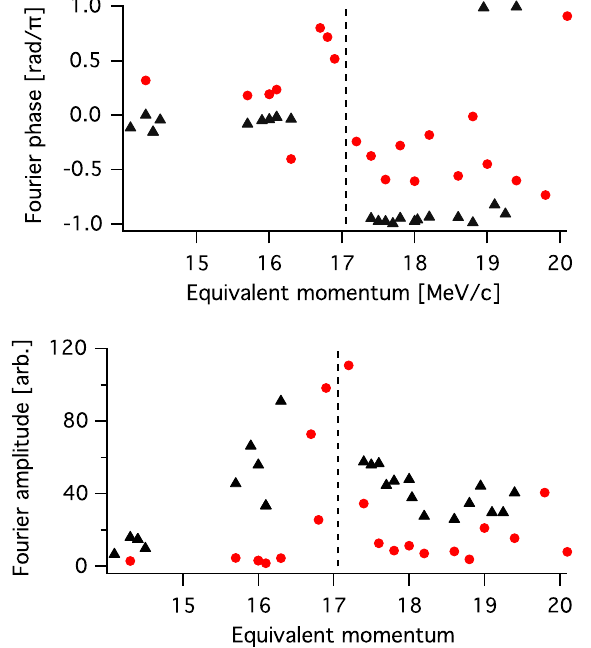
FIG. 11. Harmonic 7 phase (top panel) and amplitude (bottom panel) before (black triangles) and after (red dots) correction obtained from horizontal COD measurements. The vertical line shows the approximate location of integer tune